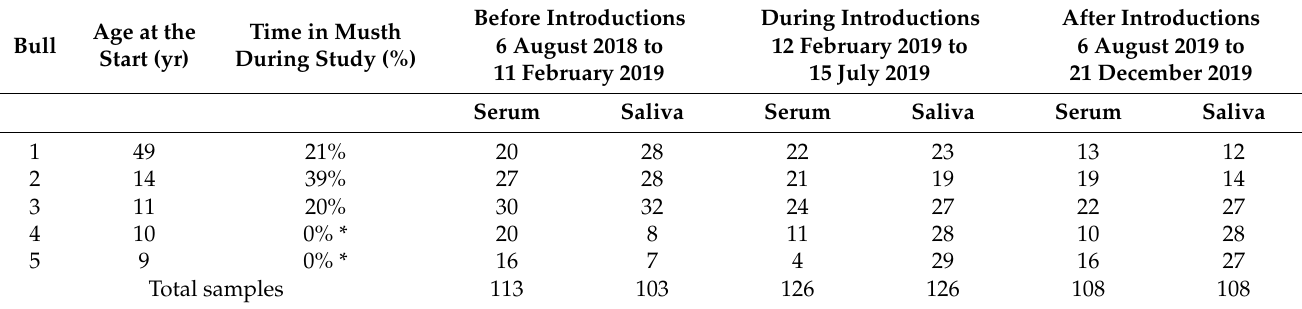
Table 1. Demographic data and serum and saliva samples collected in bull Asian elephants during socialization of two all-male